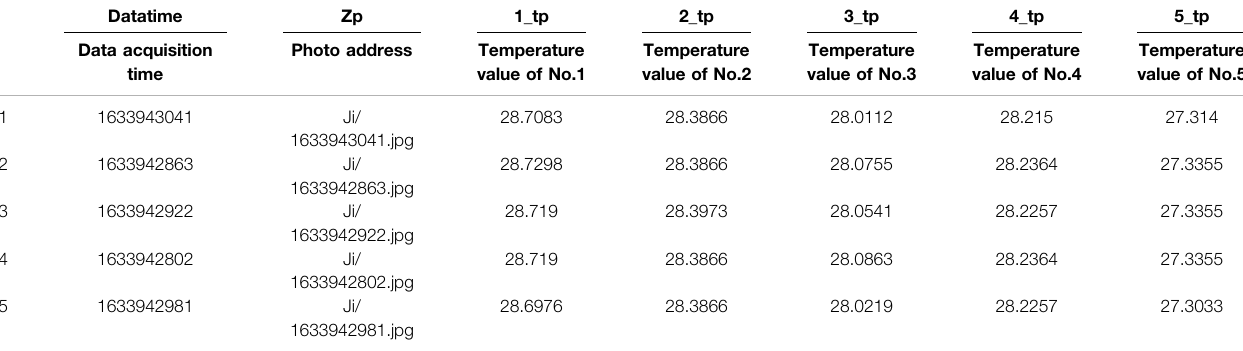
TABLE 2 | Sample data set.